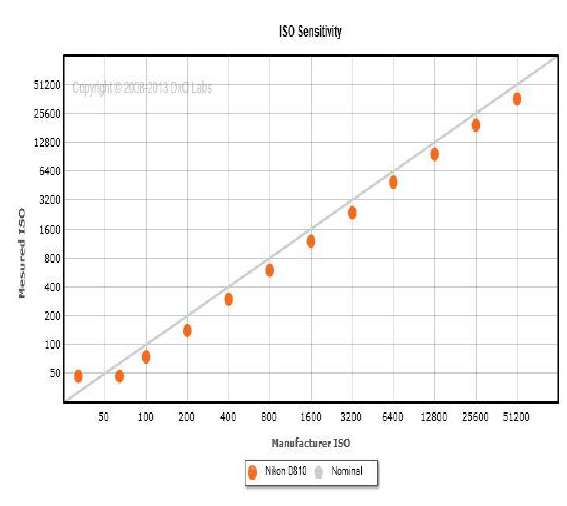
Figure 4. ISO sensitivity of the Nikon D810